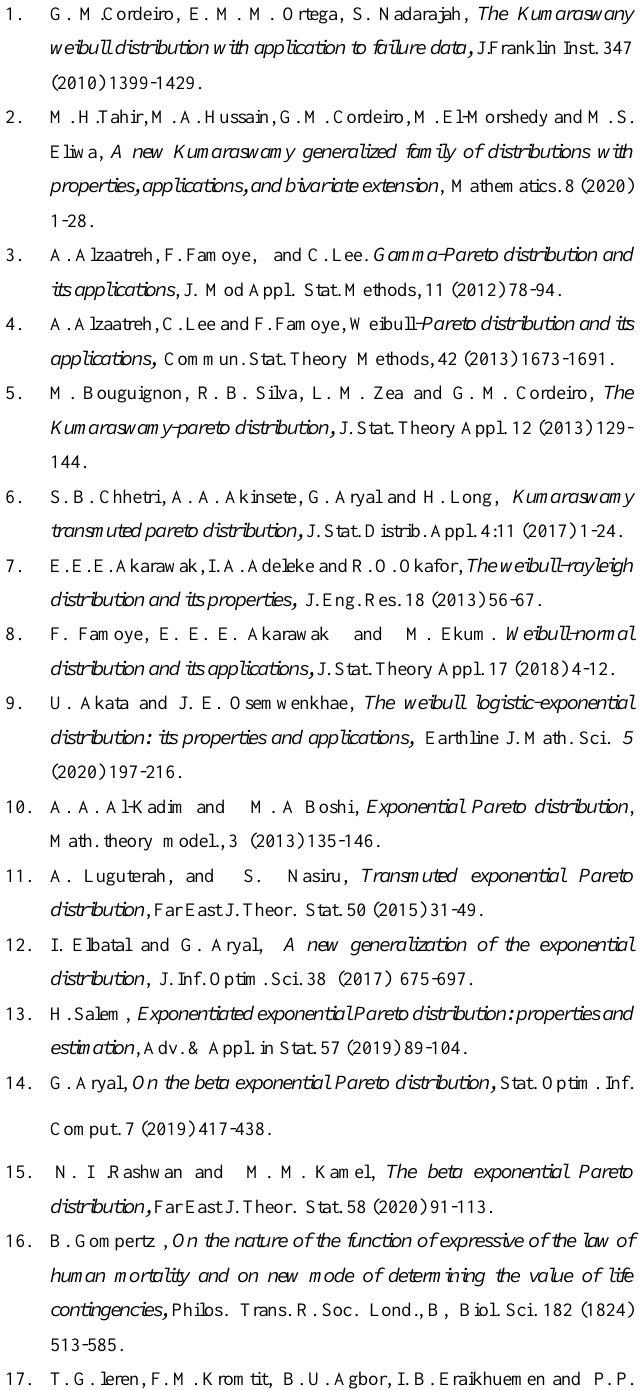
Fig. 7. The fitted densities of GEP with some competing models